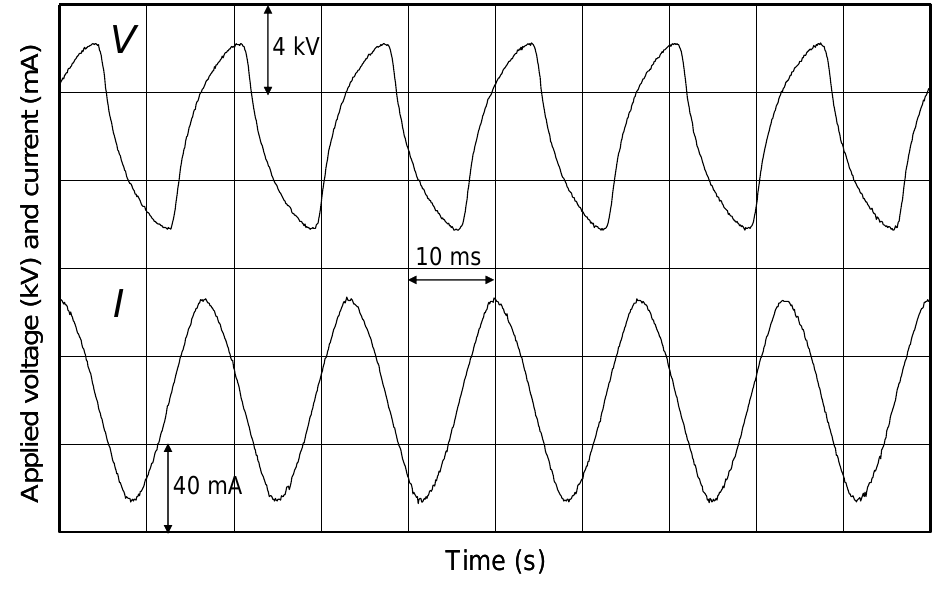
Figure 3. Applied voltage and electric current in laminated film-electrode plasma reactor.